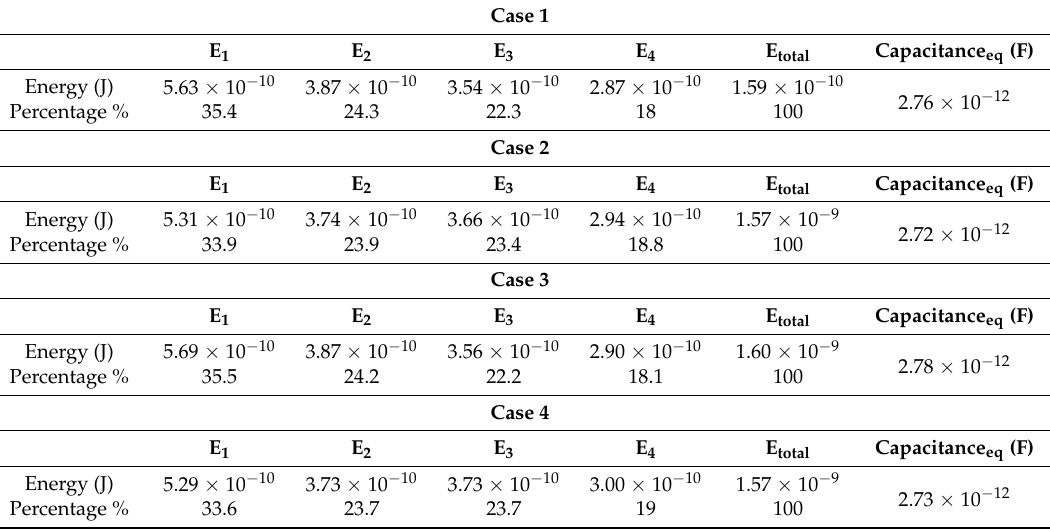
Table 5. Theoratical analysis of all presented prototypes, calculated energy, and inter-winding